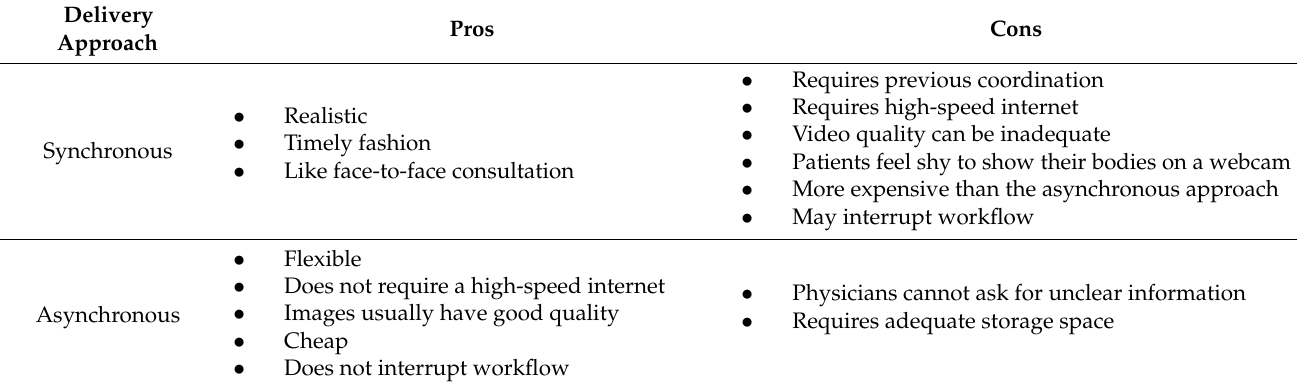
Table 1. Pros and cons of the synchronous and asynchronous approaches of telemedicine delivery. Delivery